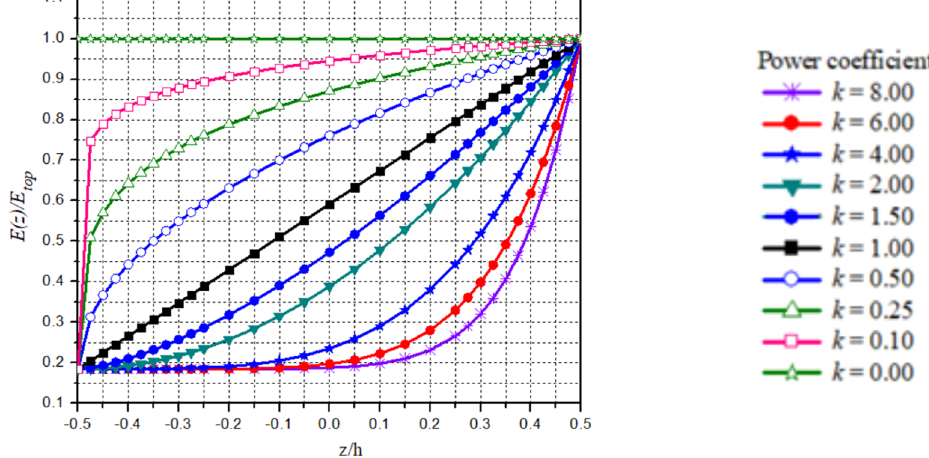
Figure 3. Variation of material Power Law for different values of power coefficient k .